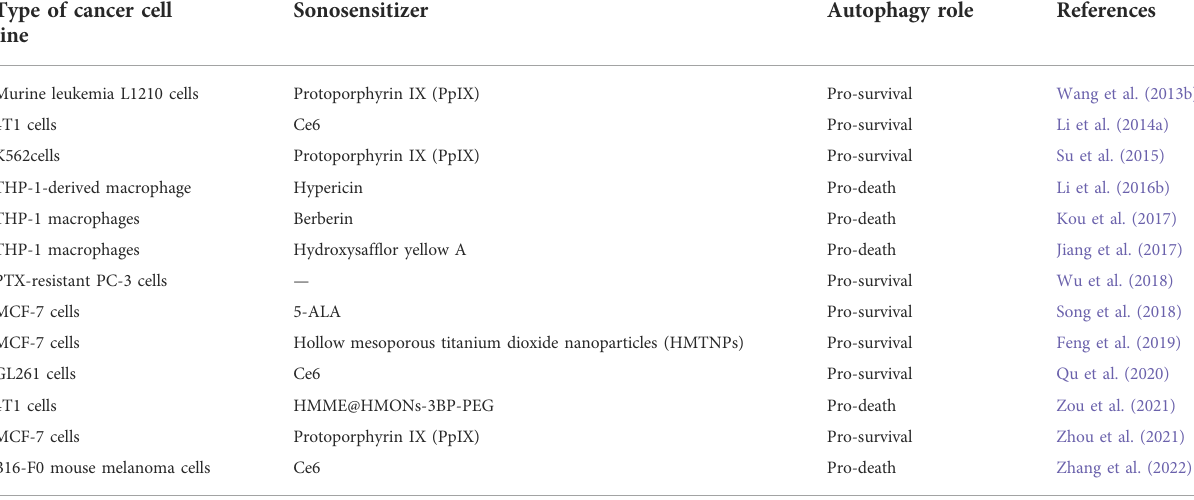
TABLE 4 Summary the autophagy activation of